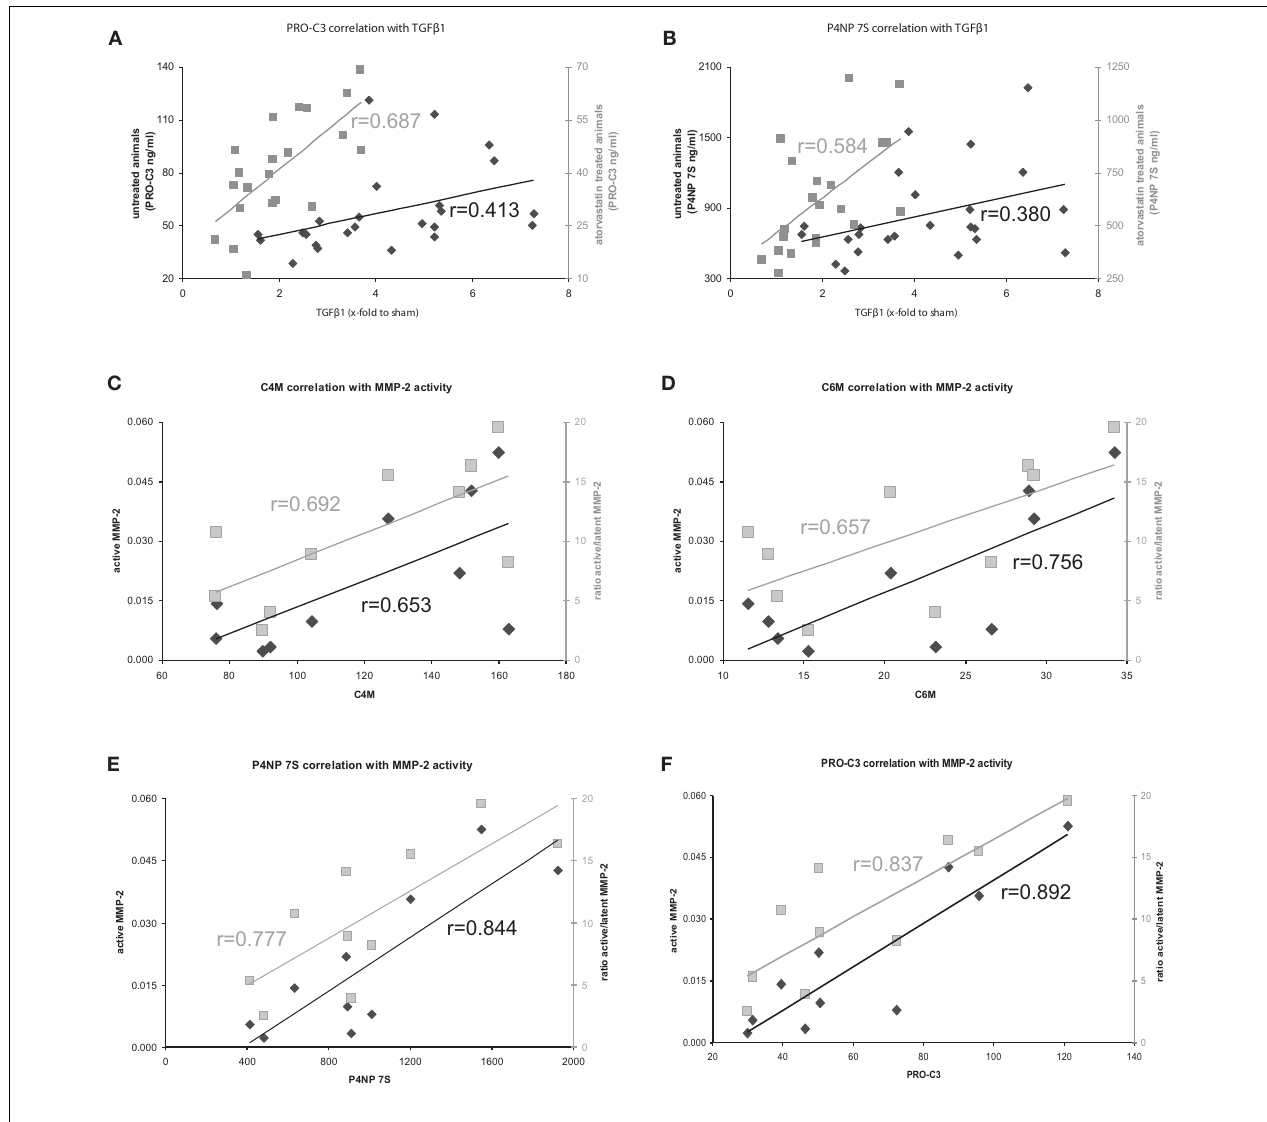
FIGURE 5 | (A,B) Correlation of formation markers with profibrotic cytokine TGF β 1 in atorvastatin treated or untreated animals. Correlations with untreated animals shown in black, correlations with atorvastatin treated